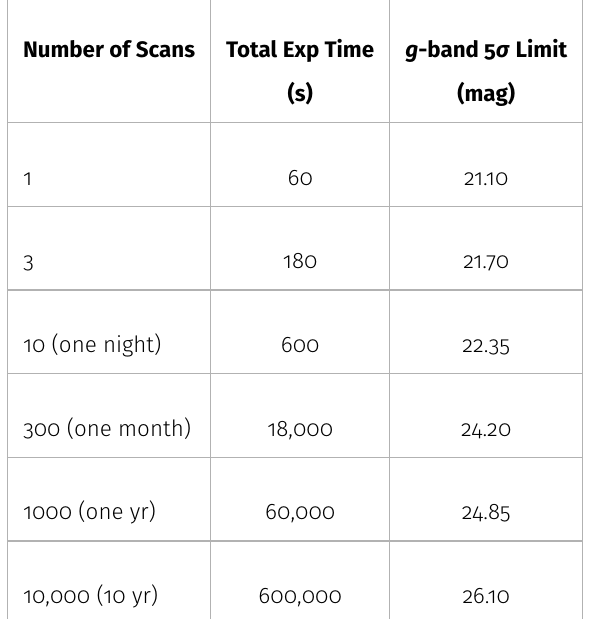
Table II. Estimated limiting magnitudes in the stacked SiTian images